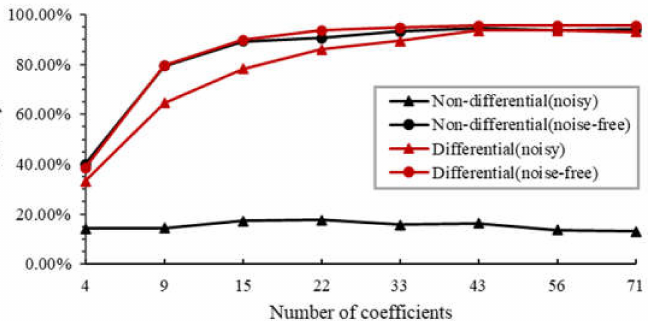
Figure 10. Simulation classification accuracy of the rotated digit on noisy and noise-free test sets with non-differential and differential